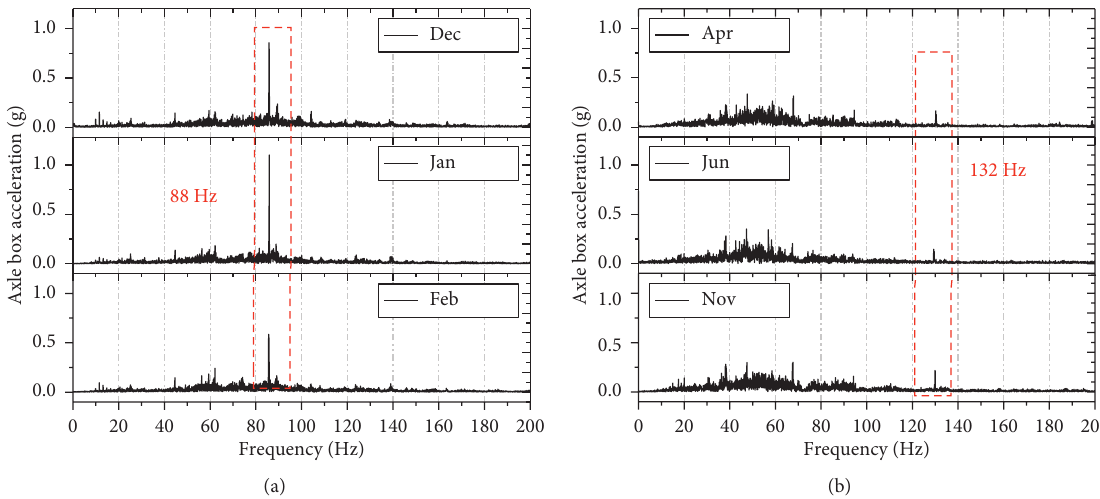
Figure 9: Comparison of frequency spectra of axle box accelerations obtained in different seasons: (a) the winter season (200 km/h); (b) the summer season (300